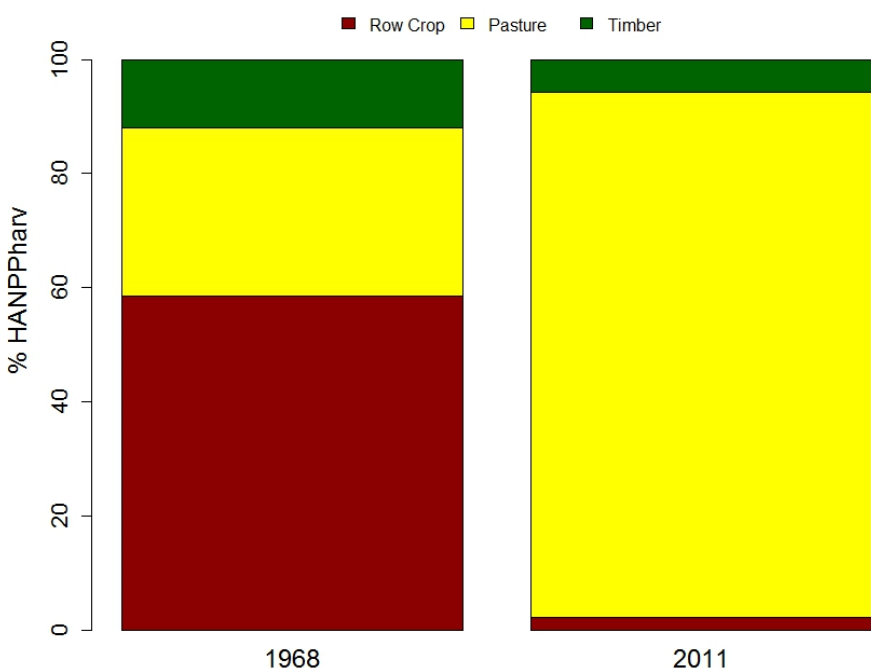
Figure 7. Percent of HANPPharv for 1968 and 2011 for row crop, pasture, and timber harvest. Calculated as HANPP harv = HANPP harvH − NPP FR + HANPP harvR + HANPP harvW